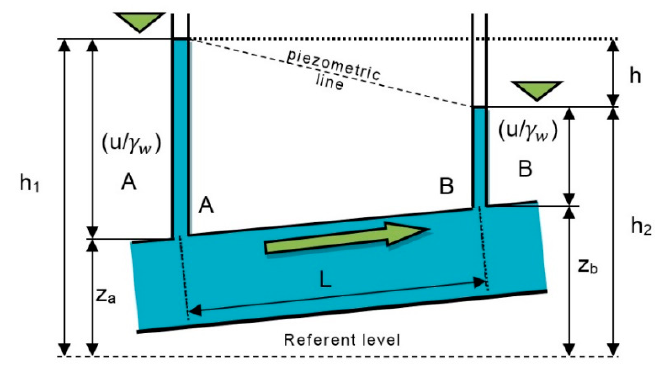
Figure 6. Darcy’s law—flow in porous medium.